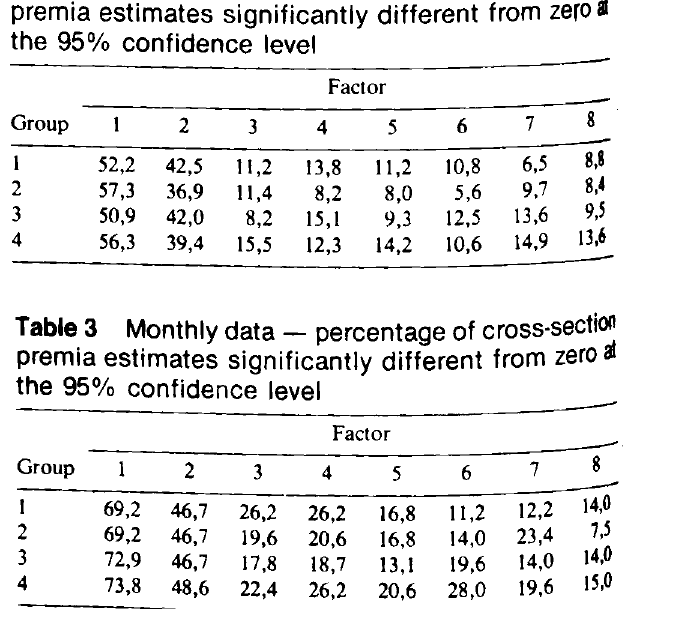
Weekly data - percentage of cross-section